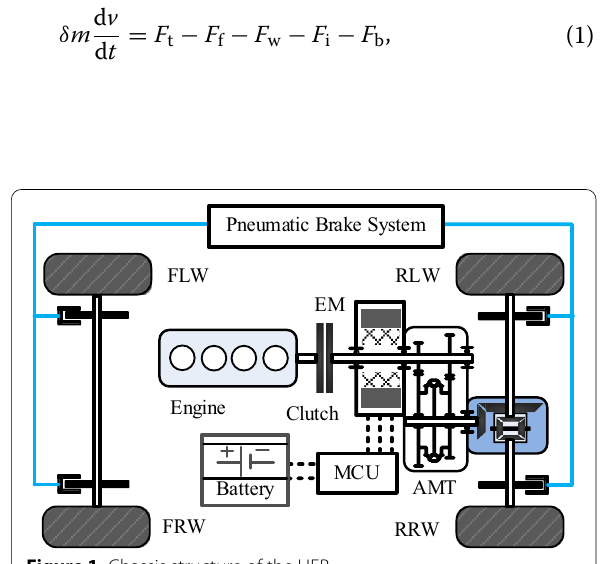
Figure 1 Chassis structure of the